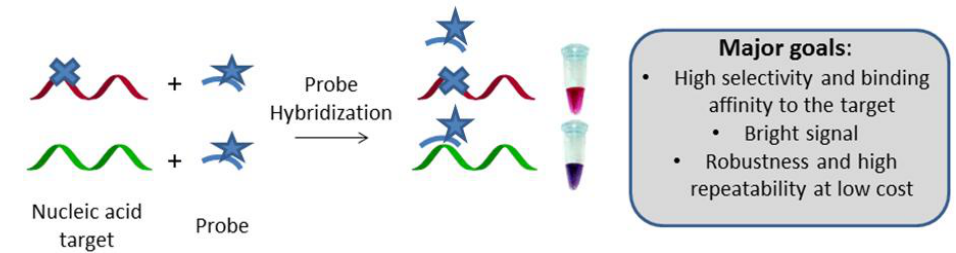
Figure 1. Representative one-step detection of single nucleotide polymorphisms (SNPs) by optical methods. SNP is indicated as a blue